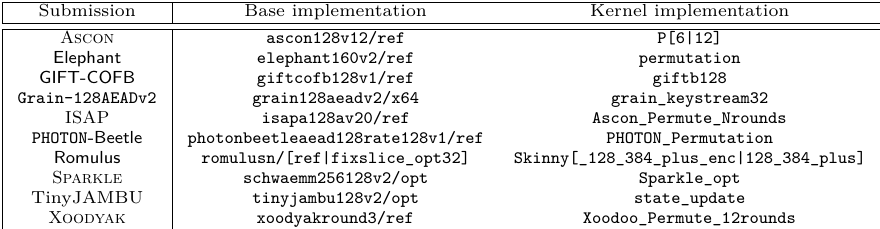
Table 1: A per-algorithm summary of the base and kernel